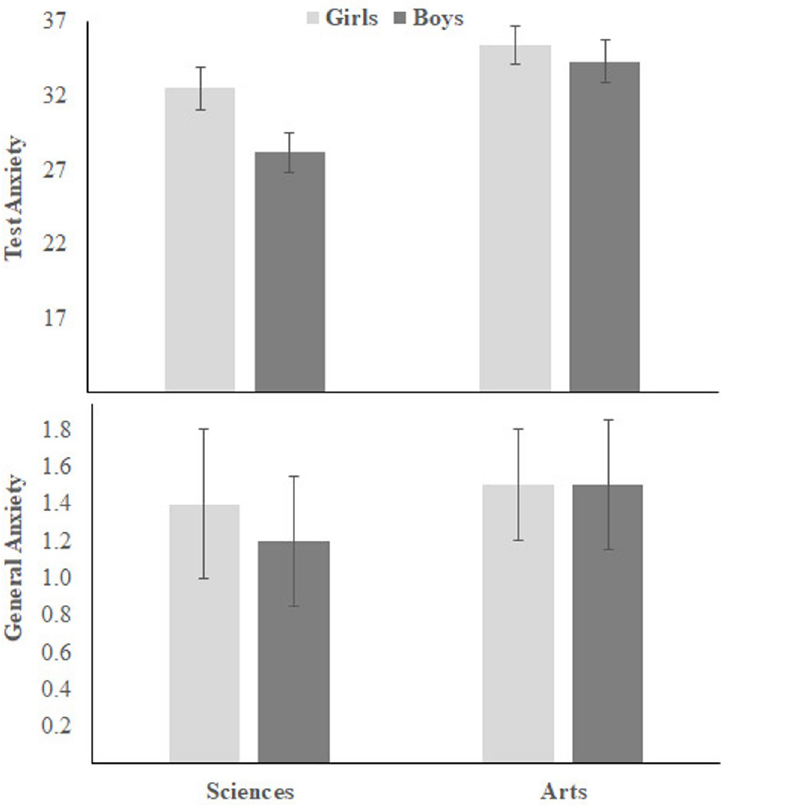
Fig 7. Gender and track differences in test anxiety and general anxiety in Study